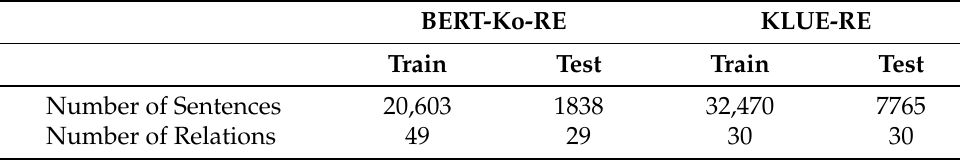
Table 3. Statistics of RE datasets in